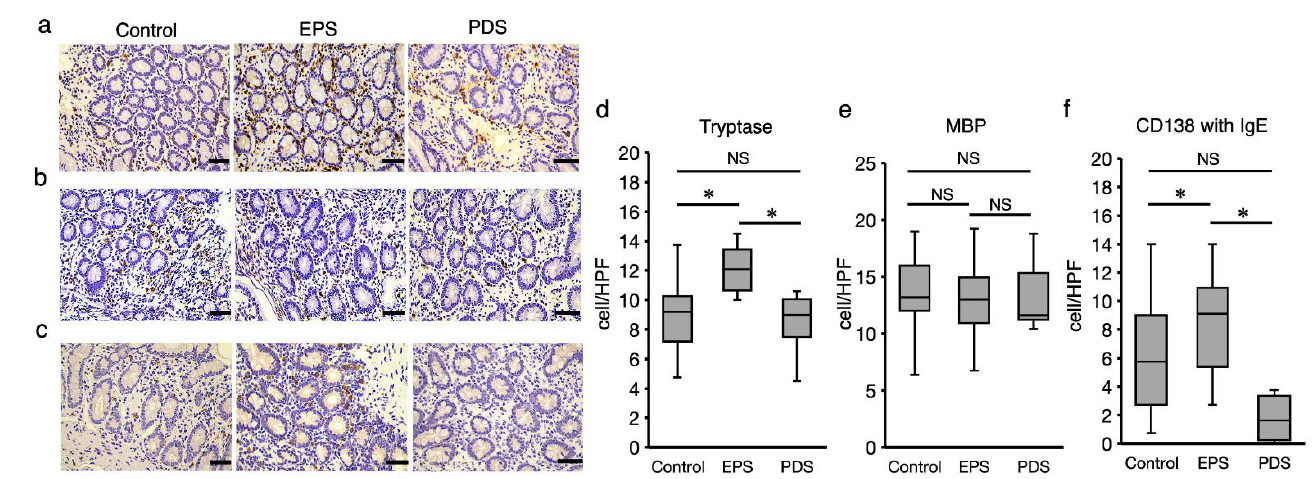
Figure 3. Infiltration of immune cells in duodenal mucosa. Duodenal biopsy specimens obtained from the EPS and PDS patients, and the healthy controls were stained immunohistochemically for mast cell using tryptase antibody ( a ), eosinophils using eosinophilic MBP antibody ( b ) and Ig-E in plasma cells using Ig-E ( c ). The immunostaining of each antibody was quantified by counting on 3 randomly selected high-power fields for each sample ( × 400 magnification) ( d , e ). The number of Ig-E-positive cells was counted within the cells that were stained with CD138, comparing with serial sections of each staining ( f ). The immune-positive cells were counted in 3 randomly selected high-power fields on each sample (controls: n = 23, EPS patients: n = 16, PDS patients: n = 11). EPS: epigastric pain syndrome, PDS: postprandial distress syndrome, MBP: major basic protein. * p < 0.05, Tukey–Kramer test, NS: not significant, Bar indicates 20 µ